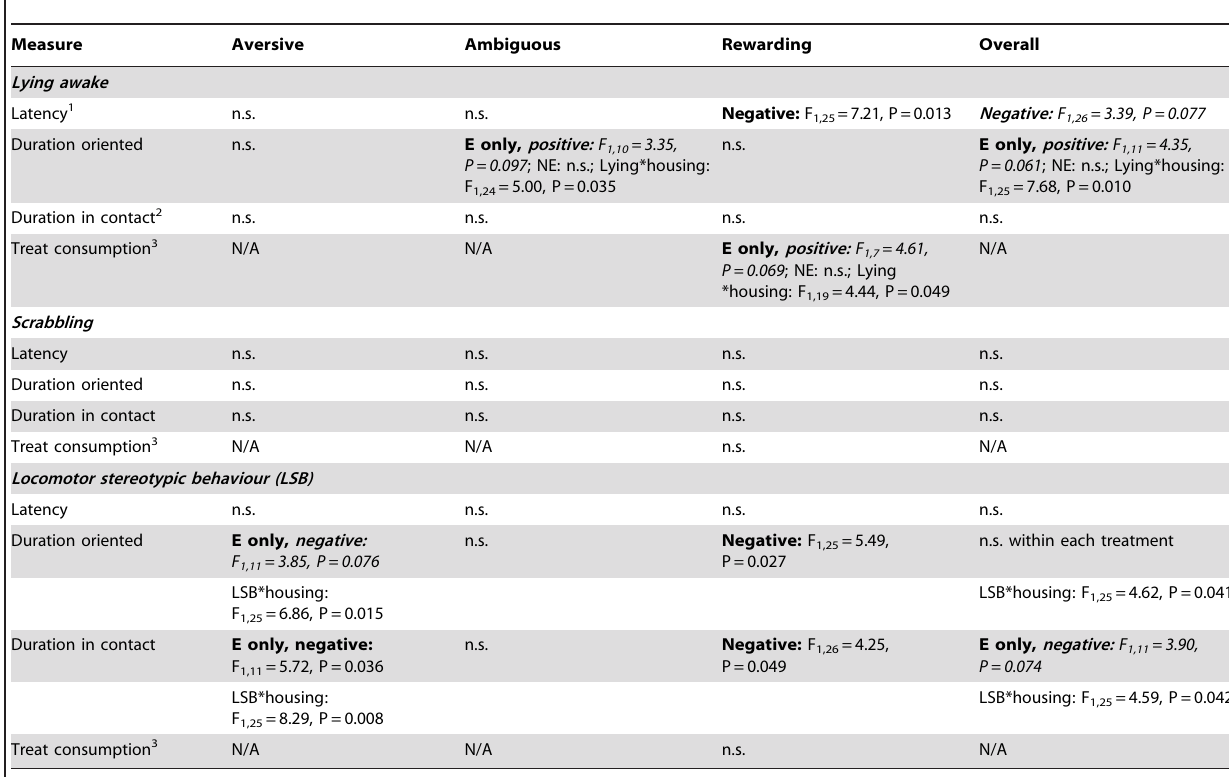
with boredom-like states. Stereotypic scrabbling showed no relationship with these indicators of boredom. These last effects all need replicating, however, since there is some risk that they were Type I errors. Table 4. Correlations between interest in stimuli and other behaviour patterns hypothesized to reflect